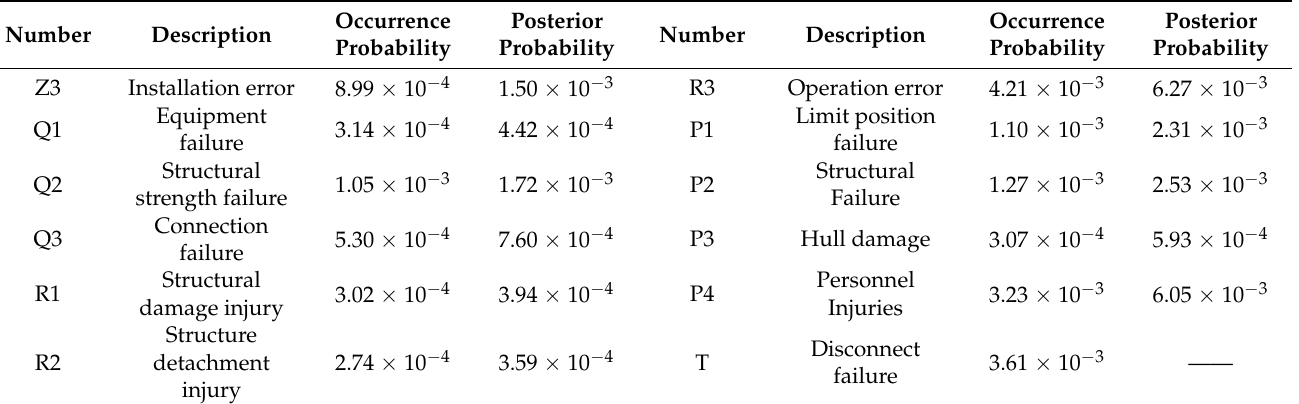
Table 10. Probability of occurrence of intermediate